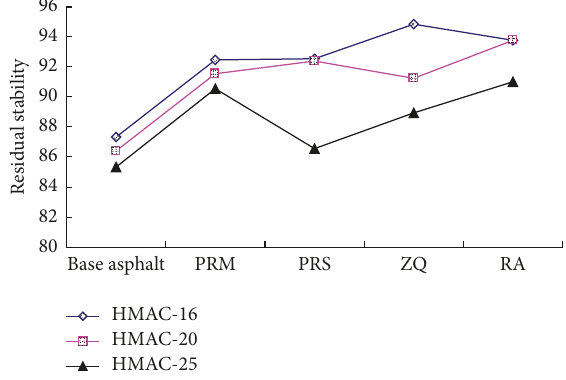
Figure 12: Residual stability of